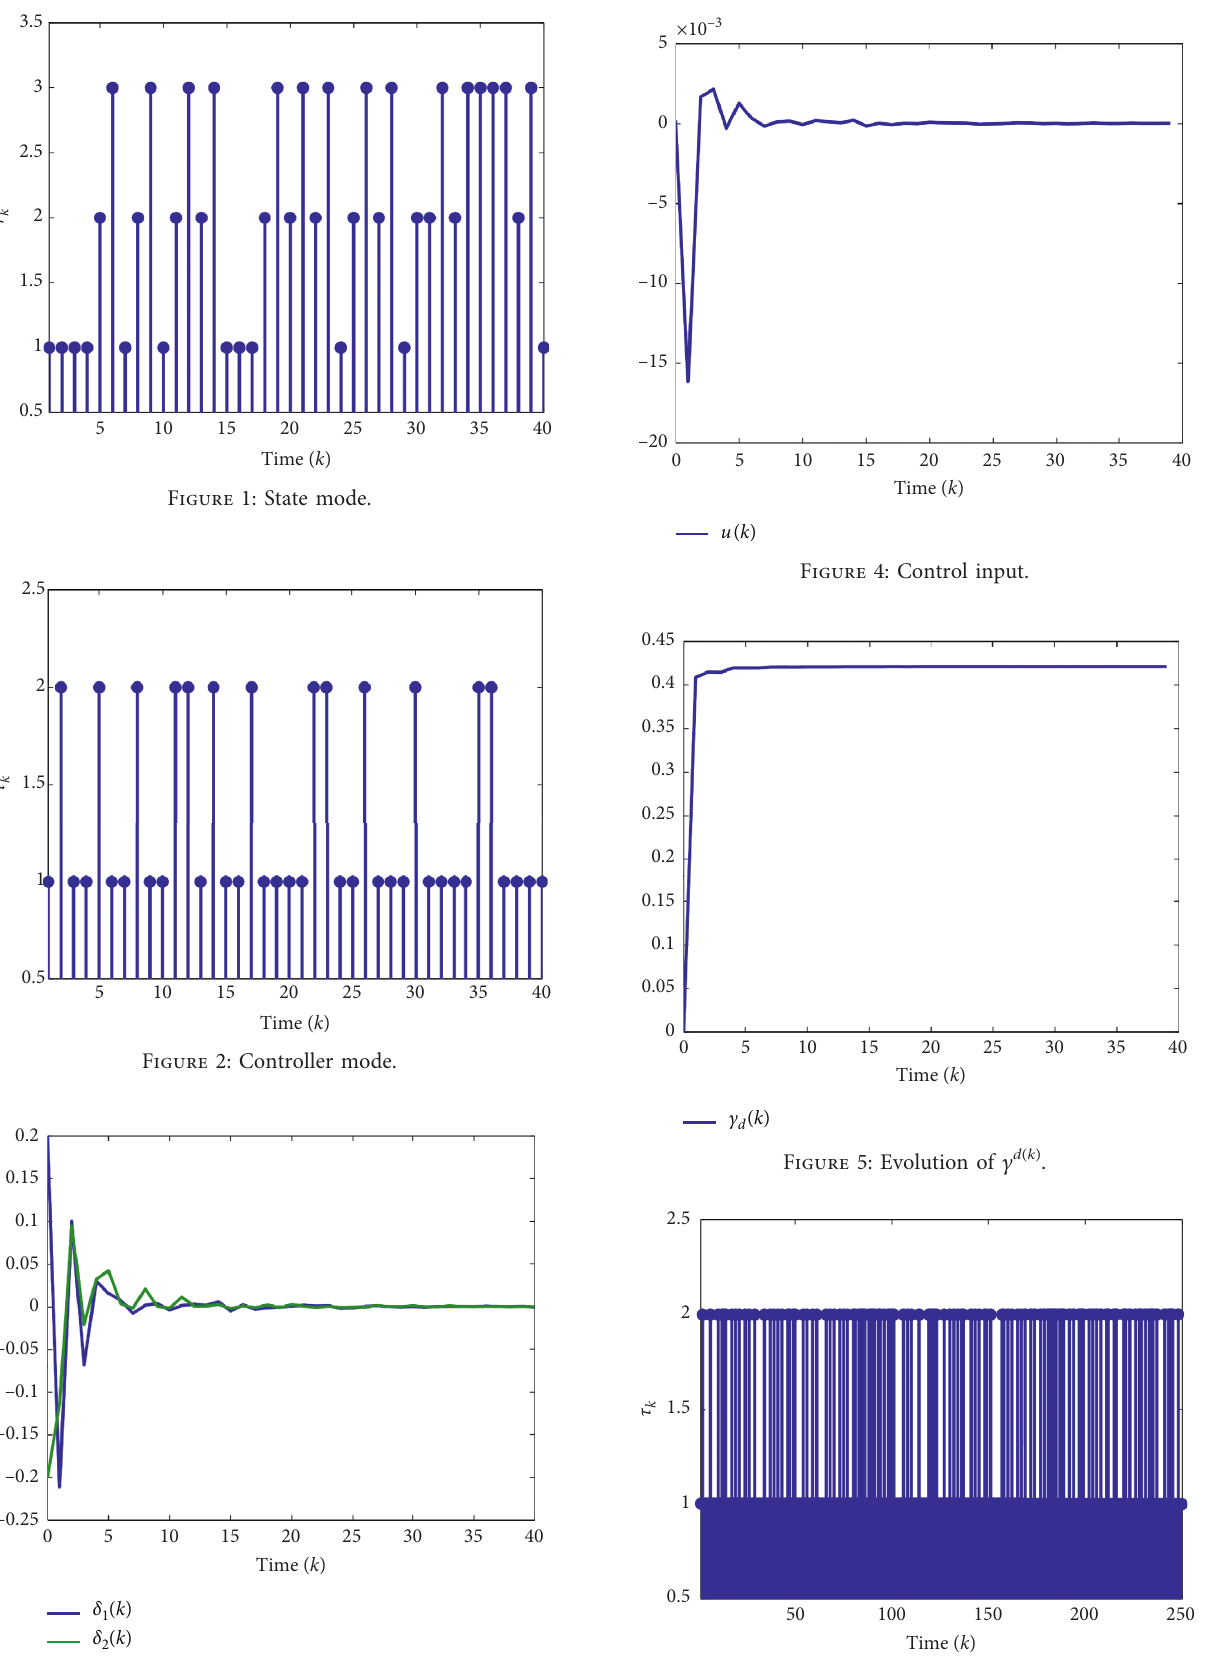
Figure 3: The state trajectories with CF.